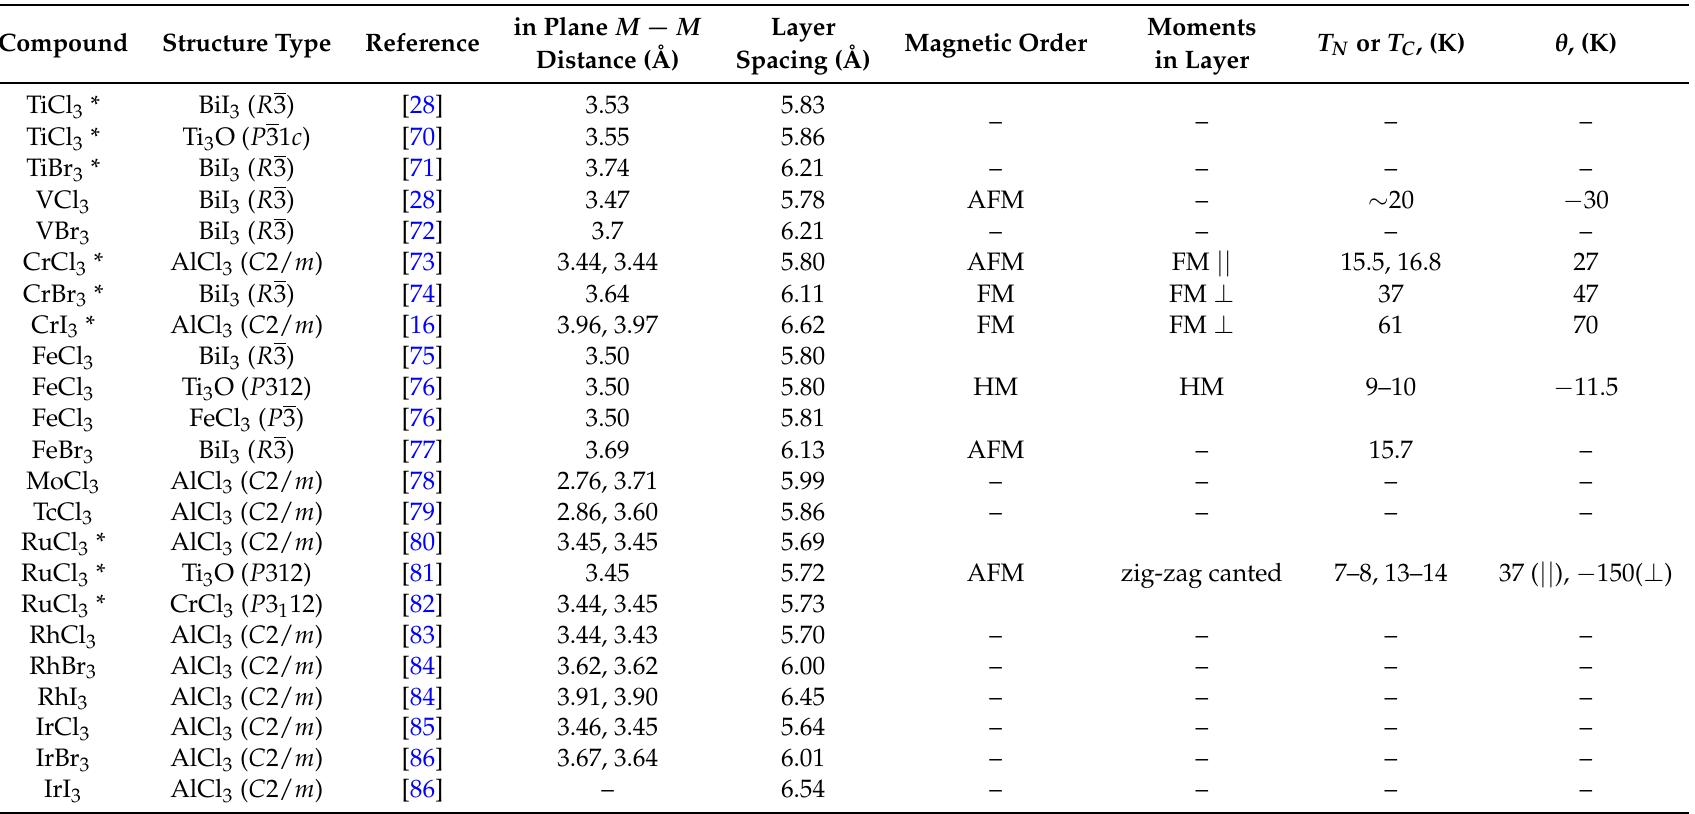
Table 2. Summary of structural and magnetic data for layered MX 3 compounds with partially filled d -shells. A * indicates that the compound is known to undergo a crystallographic phase transition above or below room temperature. Multiple reported structure types are listed for some compounds. “Magnetic order” refers to long range 3D magnetic order, and is given as antiferromagnetic (AFM), ferromagnetic (FM), or helimagnetic (HM). “Moments in layer” refers to the arrangement of the magnetic moments within a single layer, with || and ⊥ indicating whether the moments are directed parallel to the plane of the layer (in plane) or perpendicular to it (out of plane), respectively, and “canted” indicating a canting away from either of these directions. Ordering temperatures ( T N , T C ) and Weiss temperatures ( θ ) are given. References for the magnetic data can be found in the associated